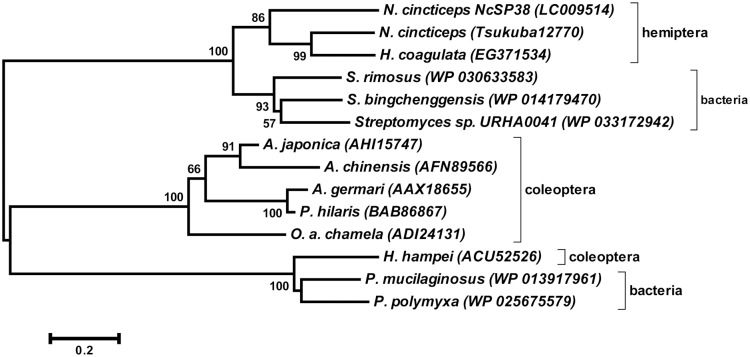
The phylogenetic tree of GH5 family protein sequences identified from Nephotettix cincticeps with GH5 proteins of six coleopteran insects and five bacterial GH5 proteins.Phylogenetic analysis was performed using deposited data from Hemiptera: Nephotettix cincticeps (NcSP38:LC009514, and TsukubaH.comp12770), Homalodisca coagulata (EG371534), Coleoptera: Hypothenemus hampei (ACU52526), Apriona germari (AAX18655), A. japonica (AHI15747), Anoplophora chinensis (AFN89566), Psacothea hilaris (BAB86867), Oncideres albomarginata chamela (ADI24131), Bacteria: Paenibacillus mucilaginosus (WP_013917961), P. polymyxa (WP_025675579), Streptomyce rimosus (WP_030596221), S. bingchenggensis (WP_01417940), and Streptomyces sp. URHA0041 (WP_033172942). These sequences were aligned using default condition of MEGA6 [41]. All positions containing gaps and missing data were eliminated. Neigbor-joining (NJ) analysis was conducted based on 164 amino acid sequences using MEGA6. Bootstrap values were calculated for 1,000 replications.